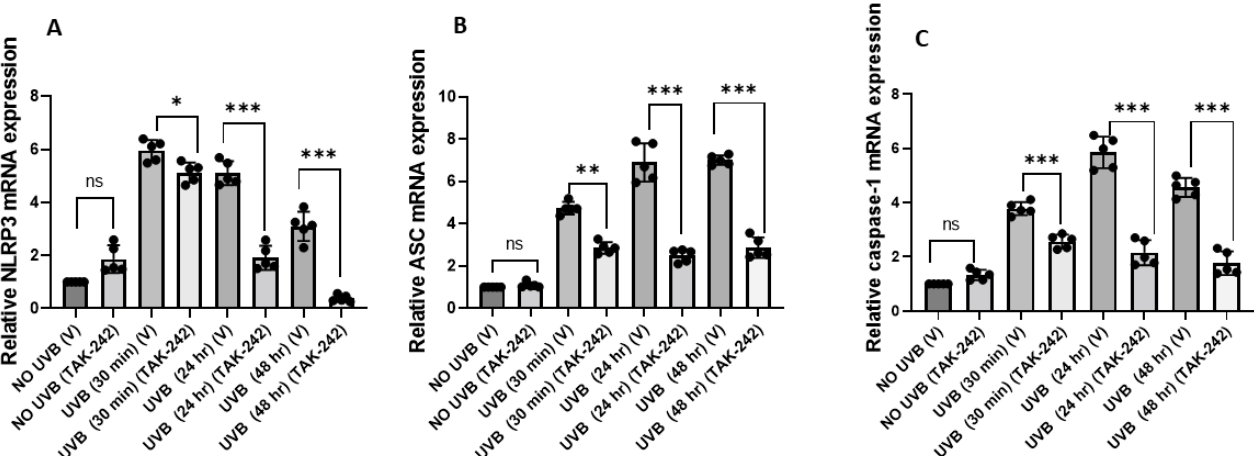
Figure 2. TLR4 inhibitor TAK-242 inhibits UVB-induced NLRP3 , Caspase-1 , and ASC activation. SKH-1 mice were exposed to a single dose of UVB radiation (100 mJ/cm 2 ) and were thereafter sacrificed at different time points. Skin samples were obtained and analyzed for, NLRP3, caspase-1, and ASC mRNA expression. ( A – C ) The expression of NLRP3, Caspase-1, and ASC were significantly lower in the skin of TAK-242 treated mice. The expression level of NLRP3 , Caspase-1 and ASC mRNA was normalized to the expression level of the GAPDH mRNA in each sample as described in the Methods section. Experiments were conducted and repeated separately in 5 mice in each group with identical results. (* p < 0.05, ** p < 0.01, and *** p < 0.001 and ns, not significant).